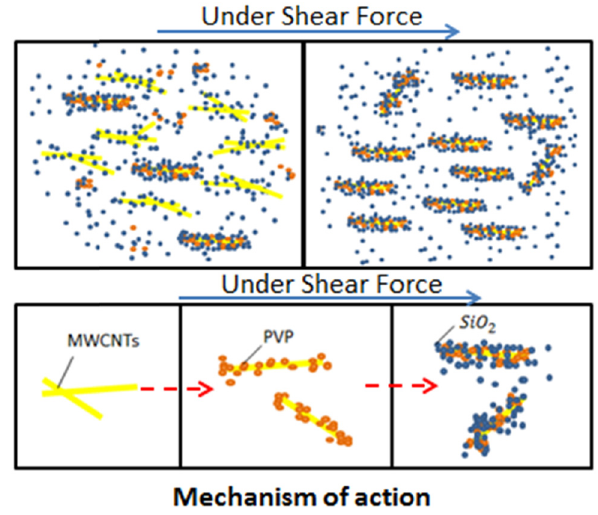
Figure 3: The MWCNTs – PVP/SiO 2 formation process.